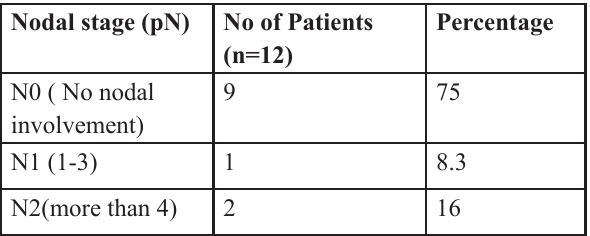
Table 4: Pathological N (pN) stage among 12 patient who had extended cholecystectomy